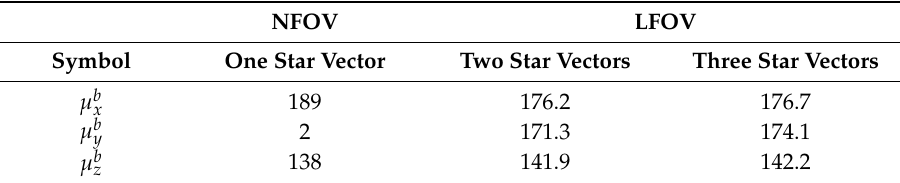
Table 1. The estimated value of installation errors in Case 1 (unit: arc-seconds).